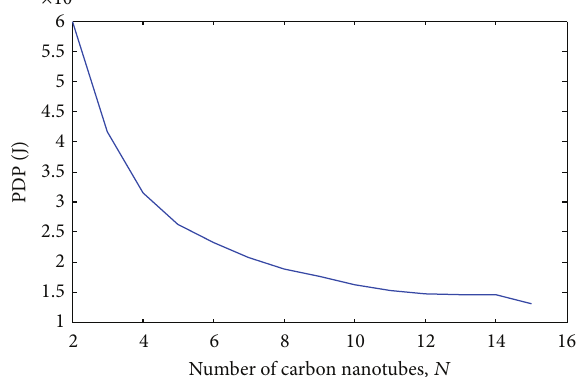
Figure 10: PDP versus number of carbon nanotubes for pure- CNFET